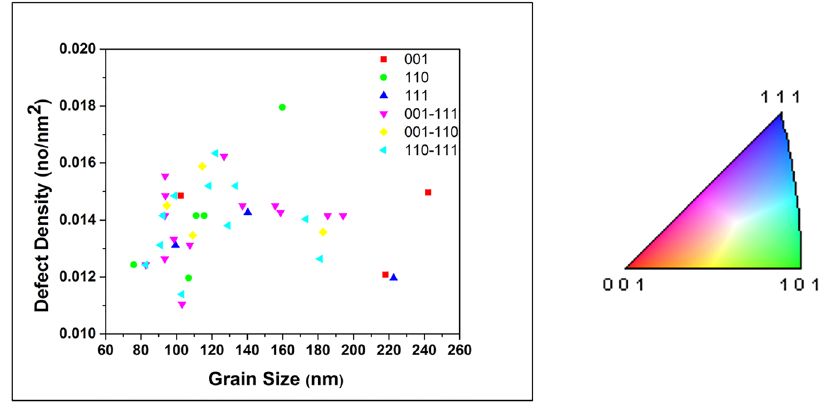
Figure 9. Loop areal density (no/nm 2 ) vs grain size (area) showing the orientations of the grains (6 different orientations extracted from the ACOM maps) of irradiated nanocrystalline Fe grains. Colors are taken to match those in the polar image (right) taken from the ACOM